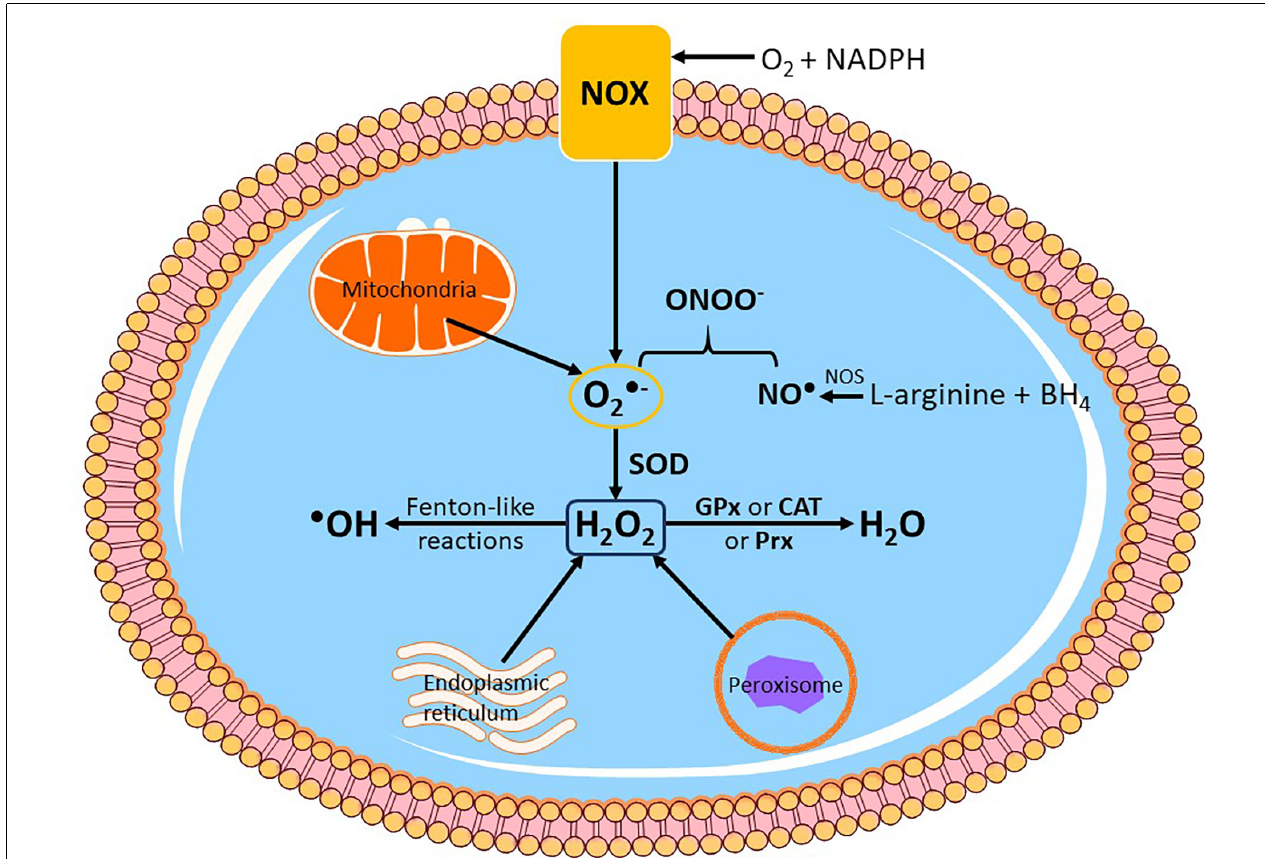
FIGURE 2 | Endogenous sources of reactive oxygen species (ROS) production. Intracellular ROS is mainly produced by subcellular organelles such as the mitochondria, endoplasmic reticulum and peroxisomes. Another enzymatic system that produces ROS and is located on the cytoplasmic membrane is